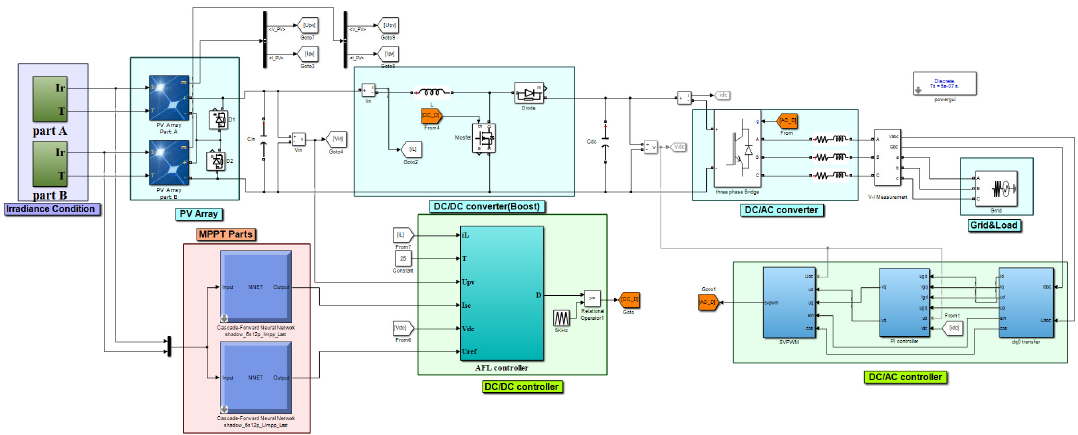
Figure B1. PV system simulation model in Matlab/Simulink.